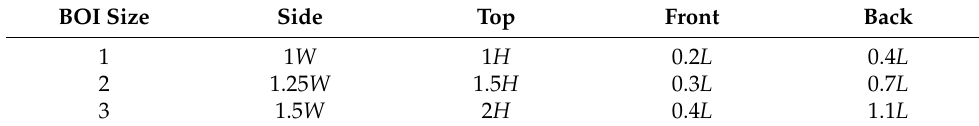
Table 1. Dimensions of the body of influence zone outside the outline of car.